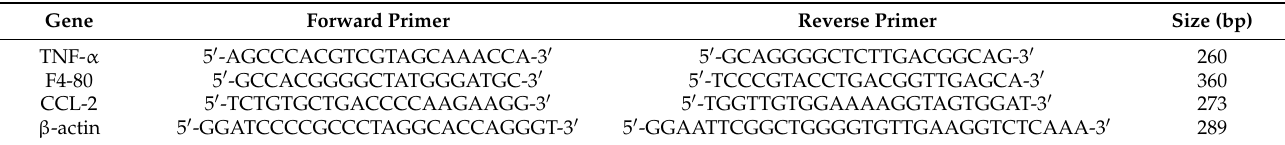
Table 1. Oligonucleotide sequence of primers for